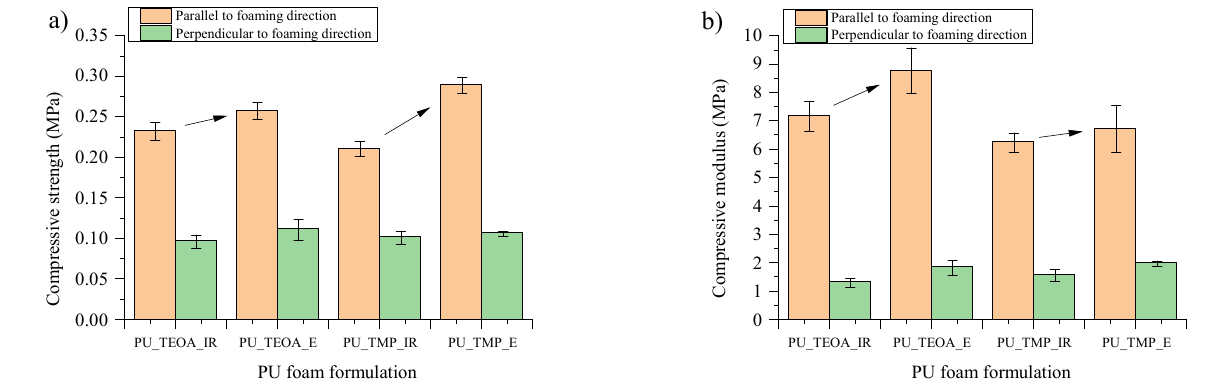
Figure 7. Compression properties ( a ) compressive strength and ( b ) compressive modulus of developed rigid PU foams normalised to the average apparent density of 40 kg/m 3 .